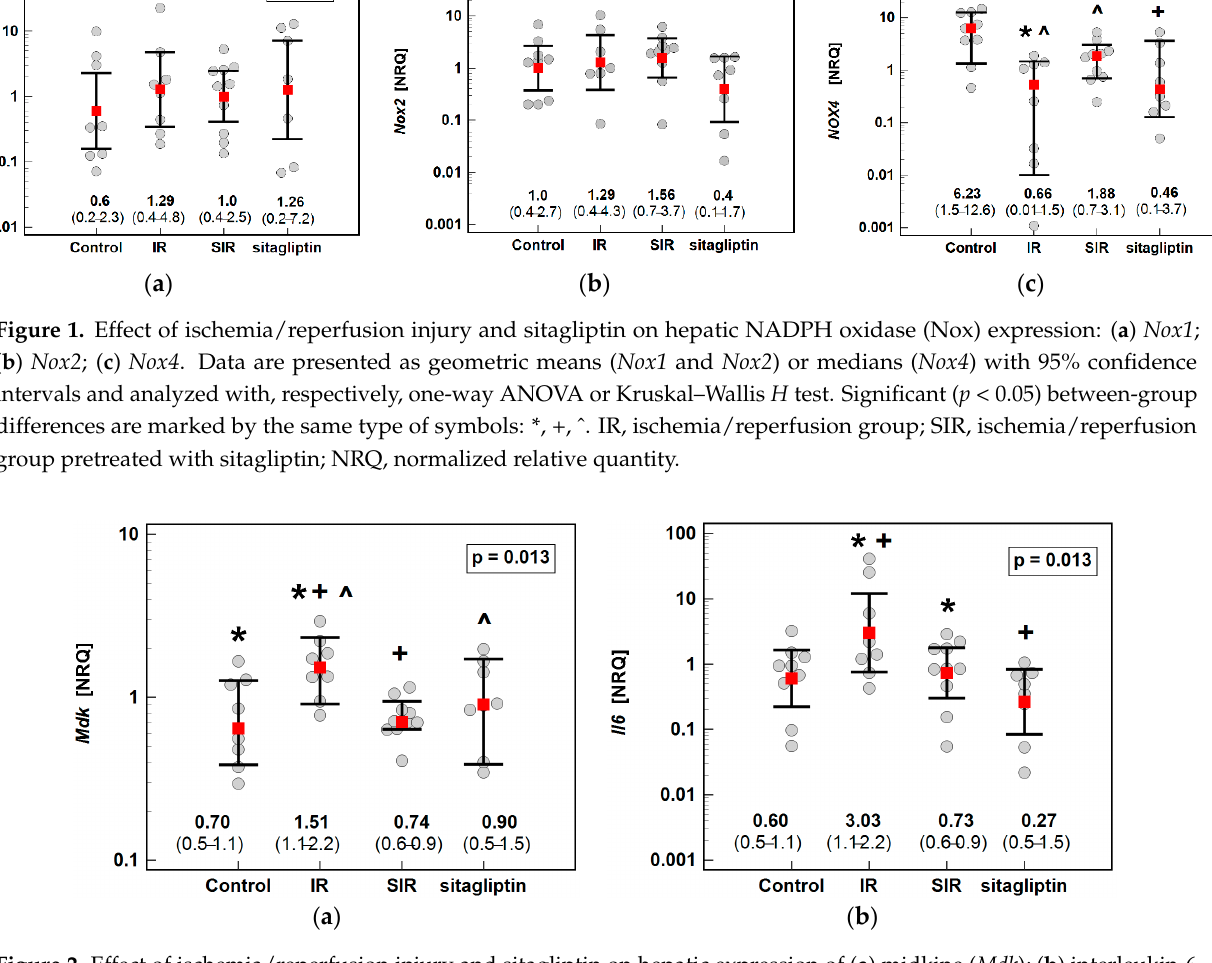
Figure 2. Effect of ischemia/reperfusion injury and sitagliptin on hepatic expression of ( a ) midkine ( Mdk ); ( b ) interleukin-6 ( Il6 ). Data are presented as geometric means with 95% confidence intervals and analyzed with one-way ANOVA. Significant ( p < 0.05) between-group differences are marked by the same type of symbols: *, +, ^. IR, ischemia/reperfusion group; SIR, ischemia/reperfusion group pretreated with sitagliptin; NRQ, normalized relative quantity. Table 2. Effect of ischemia/reperfusion (IR) injury and/or sitagliptin on hepatic expression level of selected inflammatory mediators.